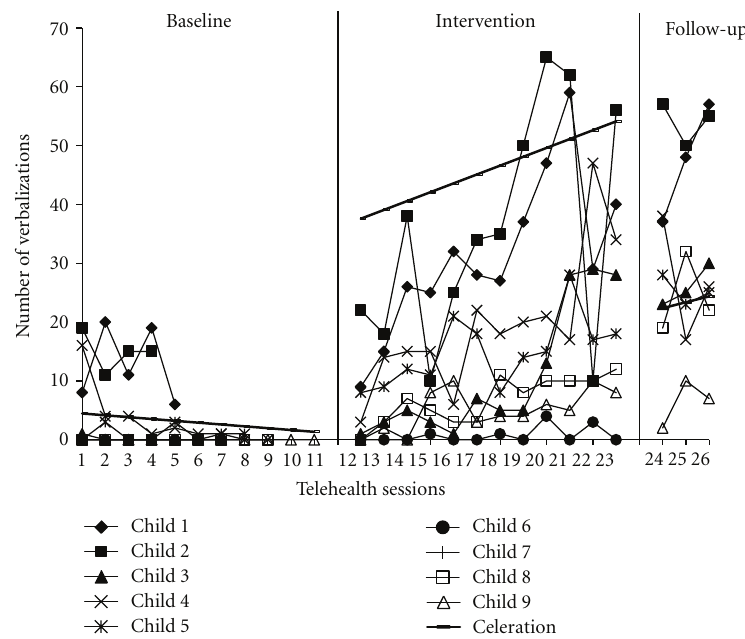
Figure 3: Individual child spontaneous language.